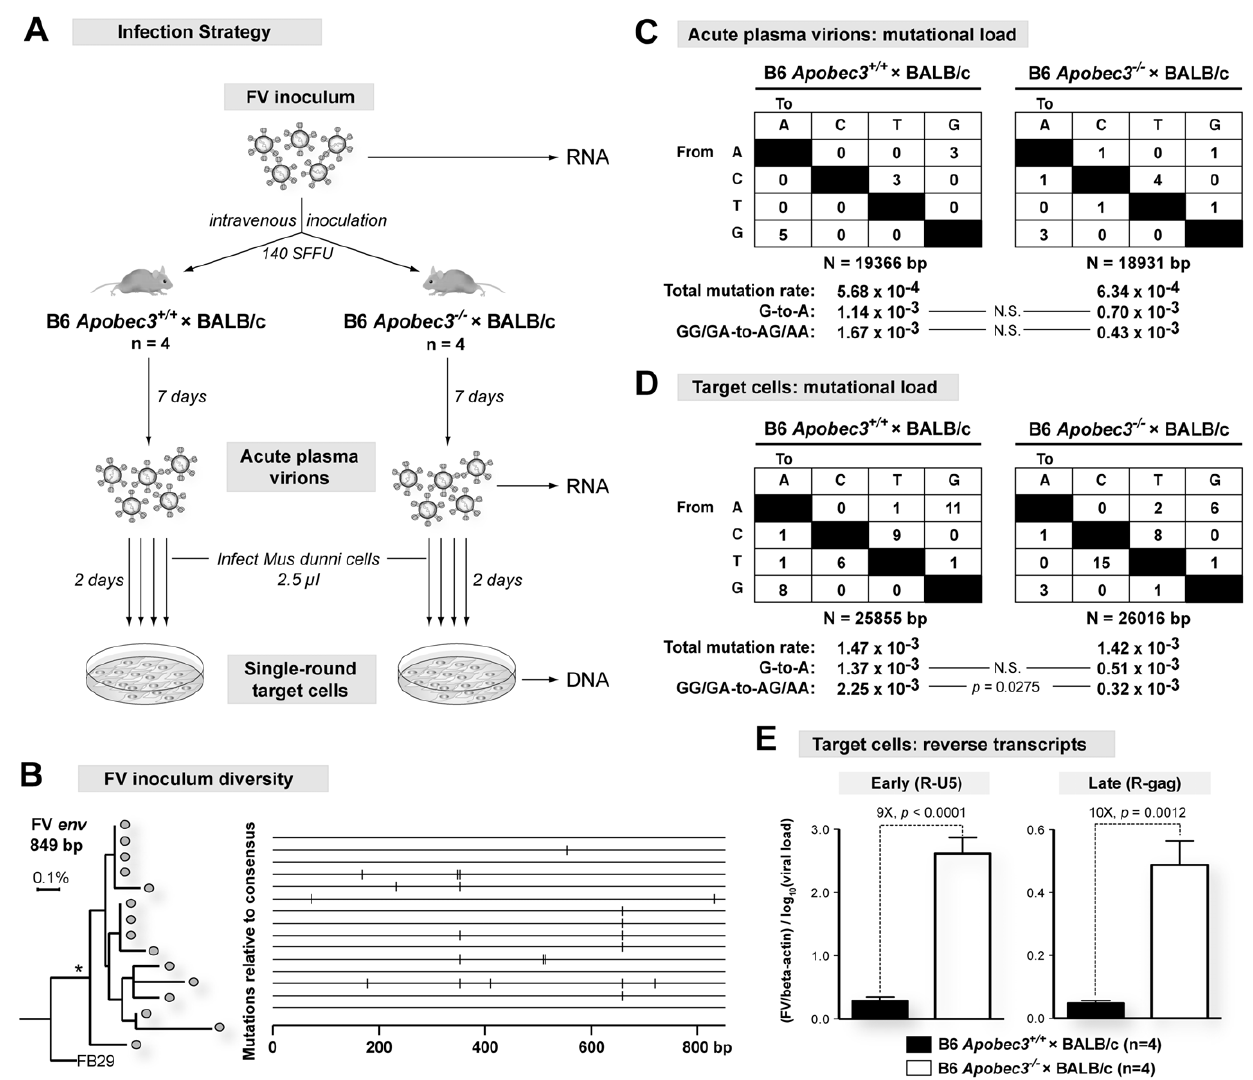
Figure 2. Mechanism of B6 mA3 inhibition of plasma virion infectivity. (A) General strategy to investigate FV evolution in vivo . FV env sequences from the inoculum stock, 7 dpi plasma, and reverse transcripts following infection of target Mus dunni cells with 7 dpi plasma were compared with each other. (B) Sequence characterization of the FV inoculum quasispecies. ( Left ) Contemporary FV sequences (gray circles) cluster in phylogenetic analyses with . 80% bootstrap value (asterisk), and diverge from a 1983 sequence, FB29. ( Right ) Sequence alignment against the consensus showed 13 variant sites (vertical bars). These variations were excluded from subsequent analyses of FV mutation rates in infected mice. The two most divergent FV sequences differed by 0.6% in nucleotide identity. (C) Virion RNA mutational loads from (B6 6 BALB/c)F 1 mice (140 SFFU) 7 dpi plasma were compared against the FV inoculum consensus. No significant difference in mutation rates was observed (Chi-Square test). (D) Reverse transcripts following infection of Mus dunni cells with plasma virions were amplified using conditions to bias for G-to-A mutational detection. Substitution rates were tabulated from a combined consensus sequence derived from the FV inoculum (panel B) and the corresponding plasma virions (panel C). mA3-associated G-to-A substitutions is associated with (B6 mA3 + / + 6 BALB/c)F 1 status by Chi-Square test. (E) mA3 inhibits FV early reverse transcription. DNA from Mus dunni cells infected for 2 days with plasma virions were subjected to quantitative PCR for early (R-U5) and late (R-gag) reverse transcripts, and normalized to beta-actin copy number and input virus. Differences in means were analyzed using a two-tailed Student’s t -test.